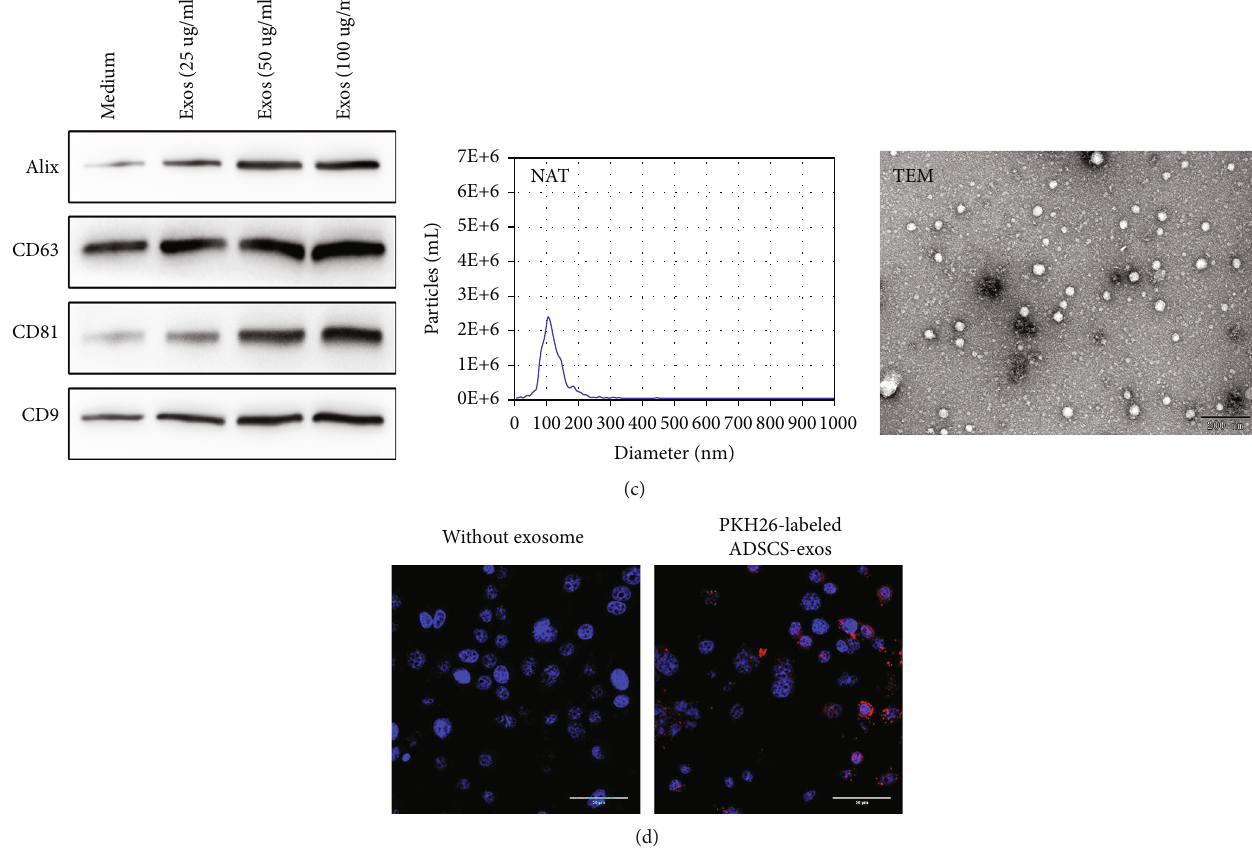
Figure 3: Characteristics of ADSCs, primary osteoblasts, and ADSCs-Exos. (a) (1) ADSCs isolated from C57/BL6 mice had a typical fi broblastic-like morphology. Alizarin Red (2), Oil Red O (3), and Alcian Blue stainings (4) were positive after the induced osteogenic, adipogenic, and chondrogenic di ff erentiations of ADSCs. The isolated ADSCs were positive for CD90 (5) while negative for CD34 (6). (b) (1) Primary osteoblasts isolated from C57/BL6 mice had shuttle, cone, or cube morphology. Alkaline phosphatase staining (2) and Alizarin Red S staining (3) were positive in the isolated osteoblasts. (c) ADSCs-Exos were positive for the exosomes ’ markers, including CD9, CD81, CD63, and Alix; NAT and TEM results showed that the isolated exosomes were in complete form with the size of 119 + 23 : 1 nm. (d) Primary osteoblasts could uptake the PKH26-labeled ADSCs-Exos. Red: PKH26-labeled ADSCs-Exos. Blue: